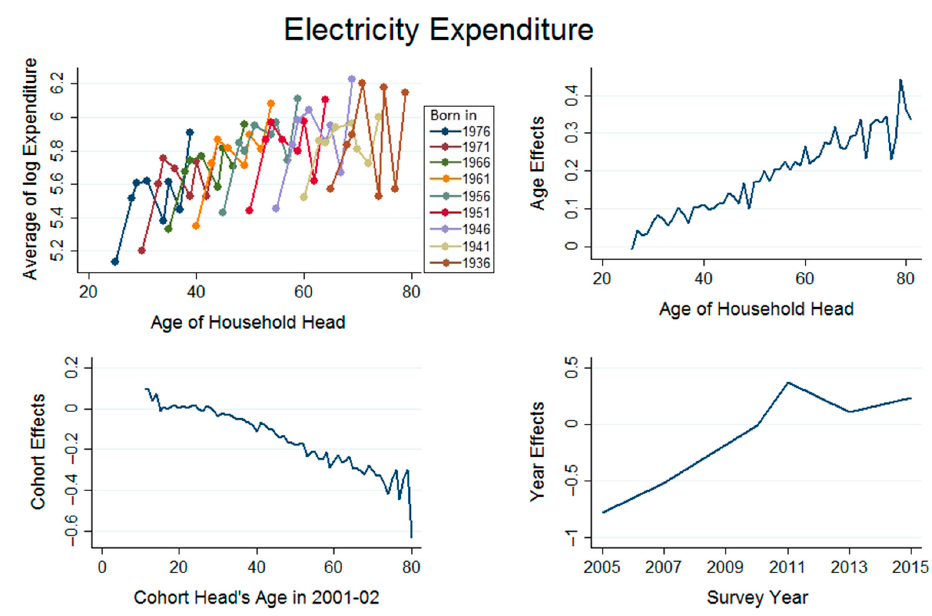
Figure 7. Electricity Expenditure.